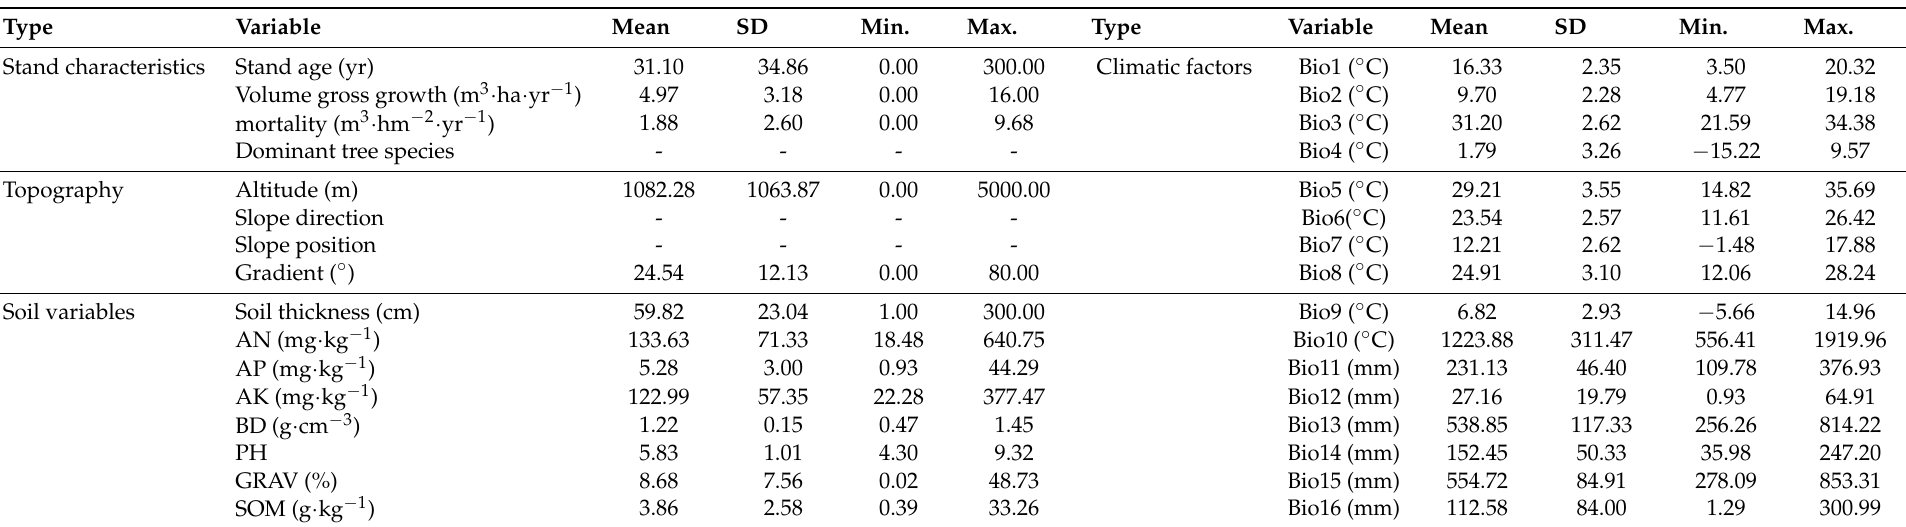
Table A2. Candidate variables for stand volume growth-loss